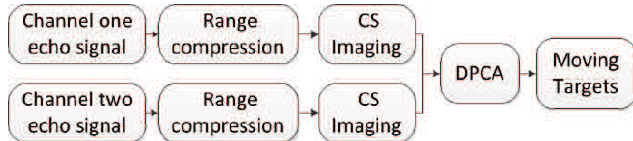
Figure 9. Flow chart of the CS-based GMTI system.